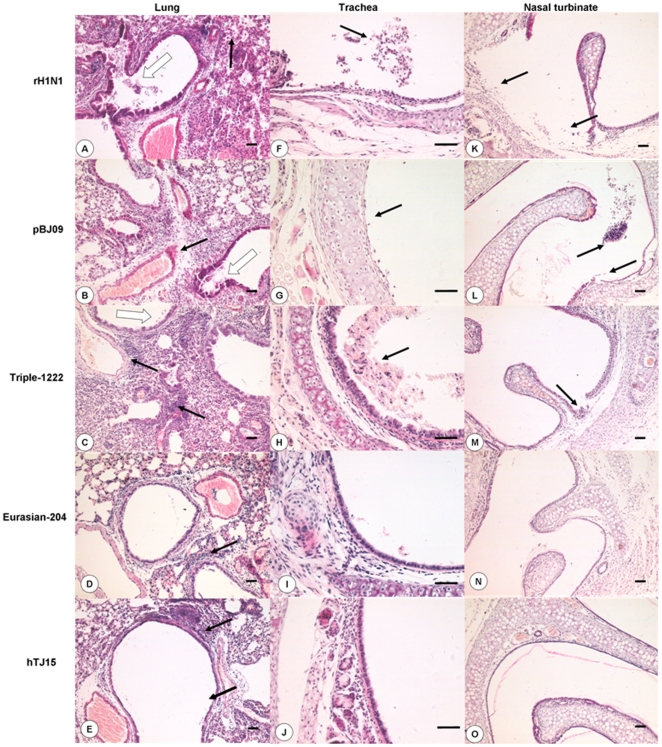
Histopathological changes in H1 virus-infected mice.Photomicrographs of H&E stained sections from nasal turbinates, trachea and lungs of mice on day 7 p.i. are shown. (
A)
 rH1N1 virus-infected lung. Observation of extensive dropout and necrosis of mucous epithelium cells (open arrows), inflammatory cell infiltration and thickening of alveolar walls (solid arrows). (
B
) pBJ09 virus-infected lung. Dropout of mucous epithelium (open arrows), interstitial edema near the small blood vessels (solid arrows). (
C
) Triple-1222 virus-infected lung. Inflammatory cells infiltrate near the blood vessels (solid arrows) and dropout of mucous epithelium cells (open arrows). (
D
) Eurasian-204 virus-infected lung. Few inflammatory cells infiltrated near the bronchiole and blood vessels (solid arrows). (
E
) hTJ15 virus-infected lung. Few inflammatory cell infiltrated near the bronchiole and blood vessels (solid arrows). (F) rH1N1 virus-infected trachea. Dropout of mucous epithelium and inflammatory cell infiltration (solid arrows). (
G
) pBJ09 virus-infected trachea. Severe dropout of mucous epithelium cells in trachea, lamina propria bareness (solid arrows). (
H
) Triple-1222 virus-infected trachea. Dropout of mucous epithelium cells and many erythrocytes (solid arrows). Eurasian-204 virus-infected trachea (
I
) and hTJ15 virus-infected trachea (J). Rare histopathologic lesion. (
K
) rH1N1 virus-infected nasal turbinate. Dropout of mucous epithelium cells (solid arrows). (
L
) pBJ09 virus-infected nasal turbinate. Extensive dropout of mucous epithelium cells in nasal turbinates (solid arrows). (
M
) Triple-1222 virus-infected nasal turbinate. Lesional tunica mucosa nasi (solid arrows). Eurasian-204 virus infected nasal turbinates (
N
) and hTJ15 virus-infected nasal turbinates (
O
). No apparent histopathologic lesion. Bar = 50 µm.